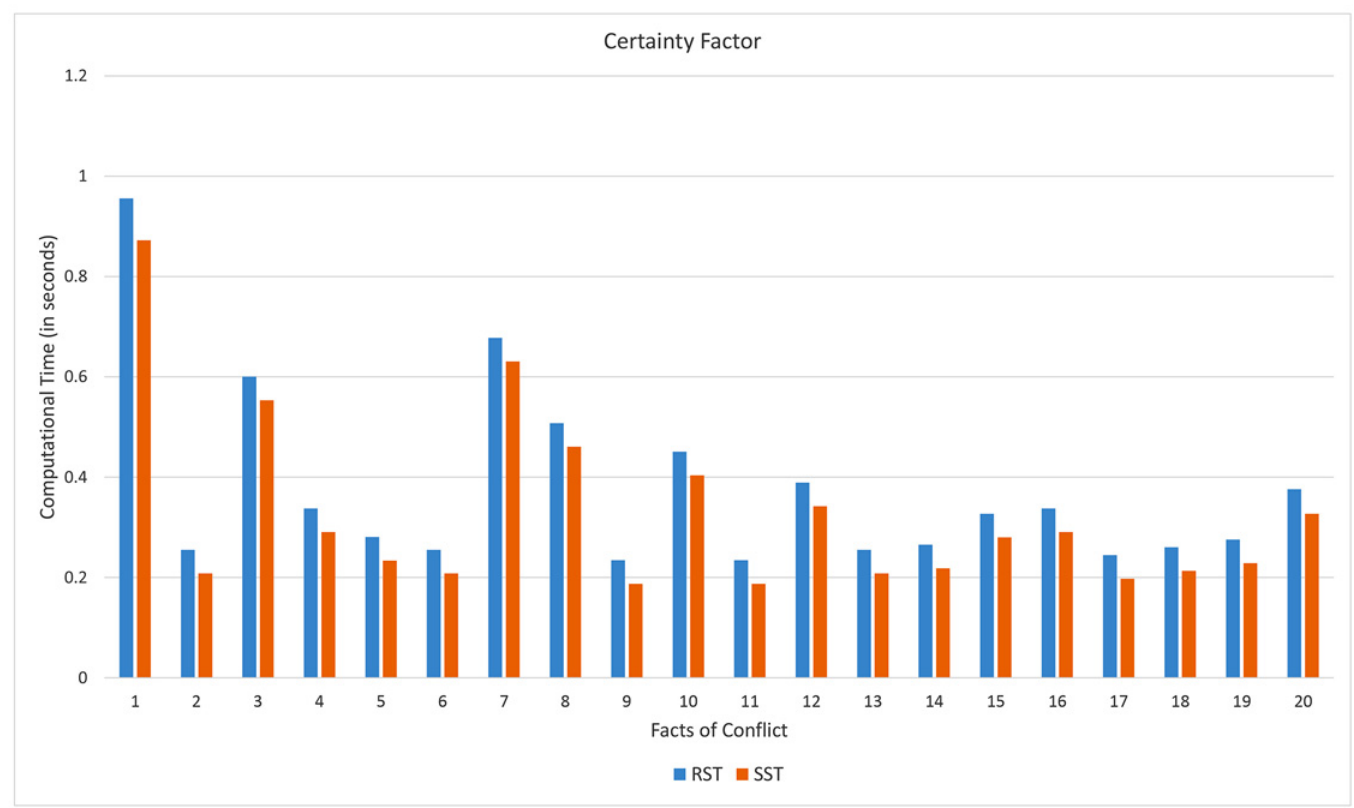
Fig 14. Computational time on computing